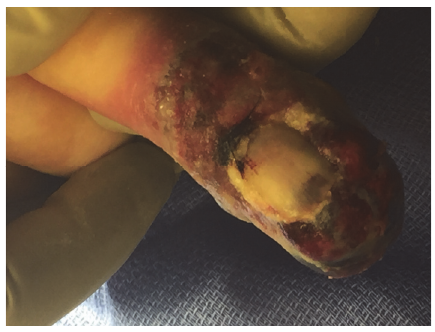
Figure 5: ADPA lesion prior to amputation, dorsal view.